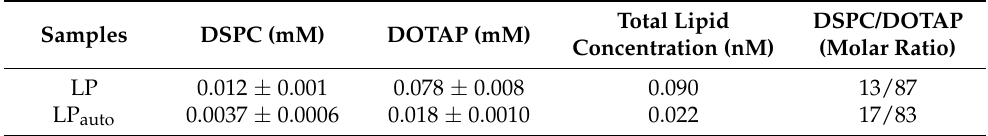
Table 3. Quantification of DSPC and DOTAP lipids contained in LP or LP auto . Values given corre- spond to the quantification of both lipids in the pellet (after removal of supernatants, i.e., removal of free lipids). Results are presented as the mean ± SD of samples ( n = 3).